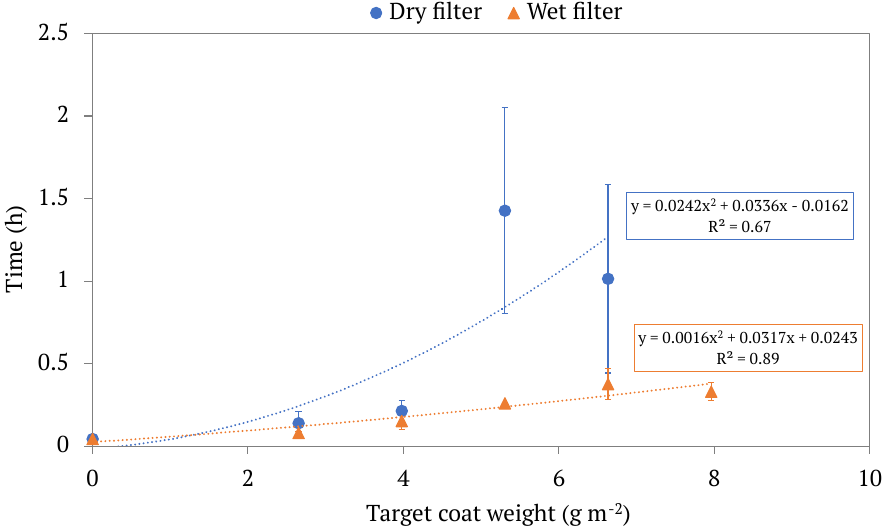
Figure 5. The filtration time of different LCNF-modified filters by coat weight. Both dry and wet filters are displayed, each set with its own respective trendline. Each point represents the average filtration time of multiple trials of modified filters with the same target coat weight, with the standard deviations of said values being displayed in the error bars.